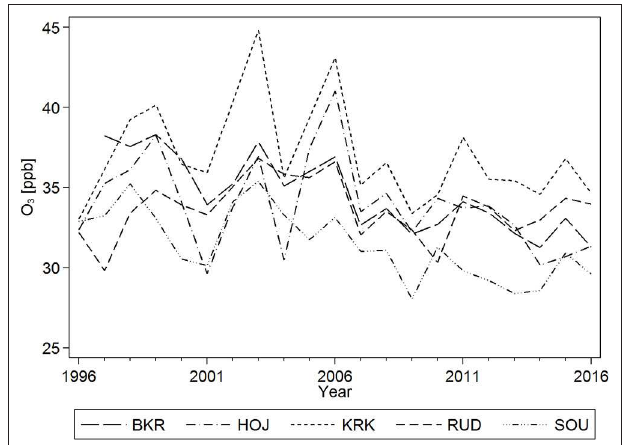
FIGURE 2 | Trend in annual median ambient O 3 levels.